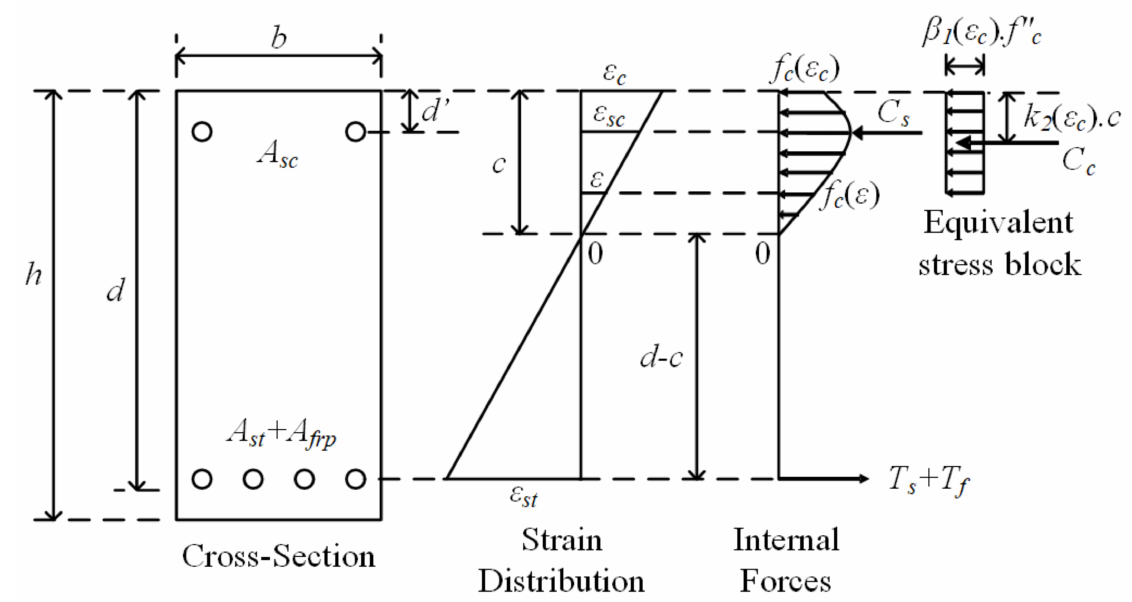
Figure 10. Strain and stress distributions in the